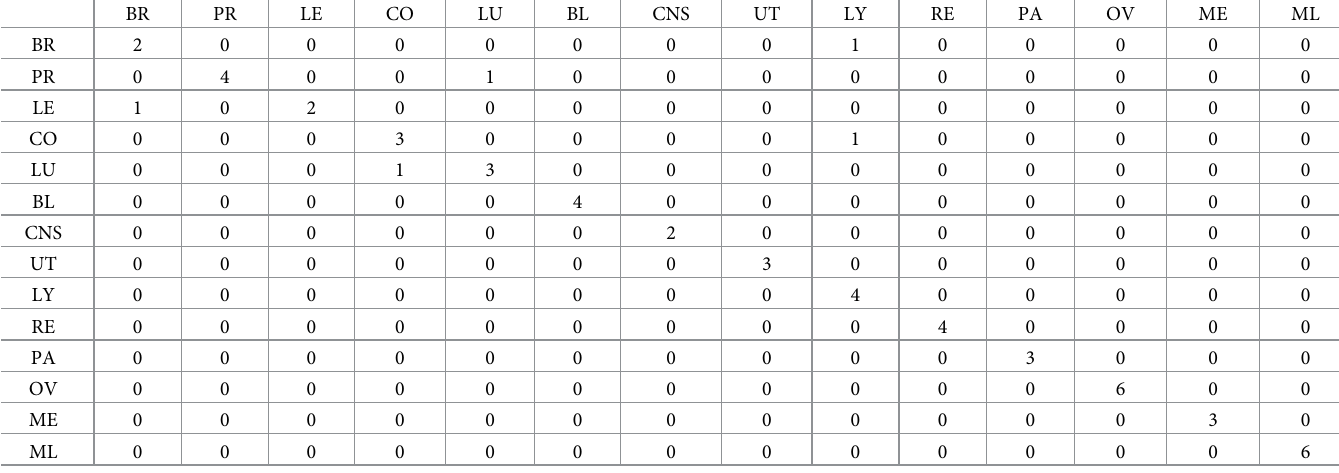
Table 5. A 14 × 14 confusion matrix: Prediction based on the LR-HeteNet method for the testing data V . BR